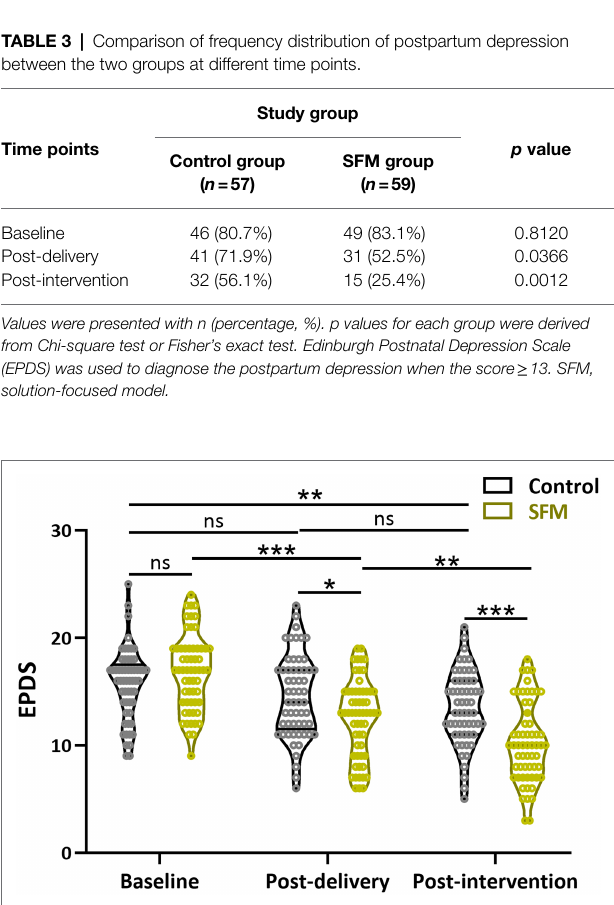
FIGURE 2 | Assessment of Edinburgh Postpartum Depression Scale (EPDS) between the two groups at different time points. Values were presented with violin plot showing all the data. * p < 0.05, ** p < 0.01, *** p < 0.001, and ns, no significance. Two-way ANOVA test followed by Turkey multiple comparisons test.